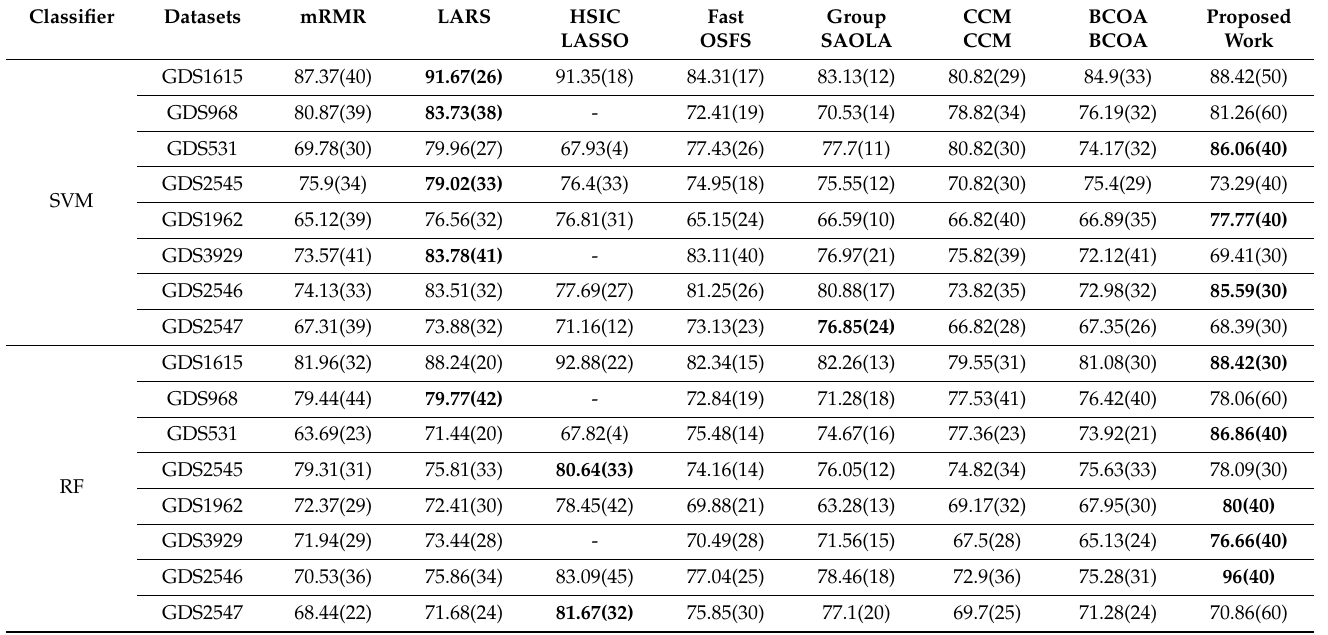
Table 3. Comparative performance of different feature selection techniques over five runs for each method. Format: accuracy (number of